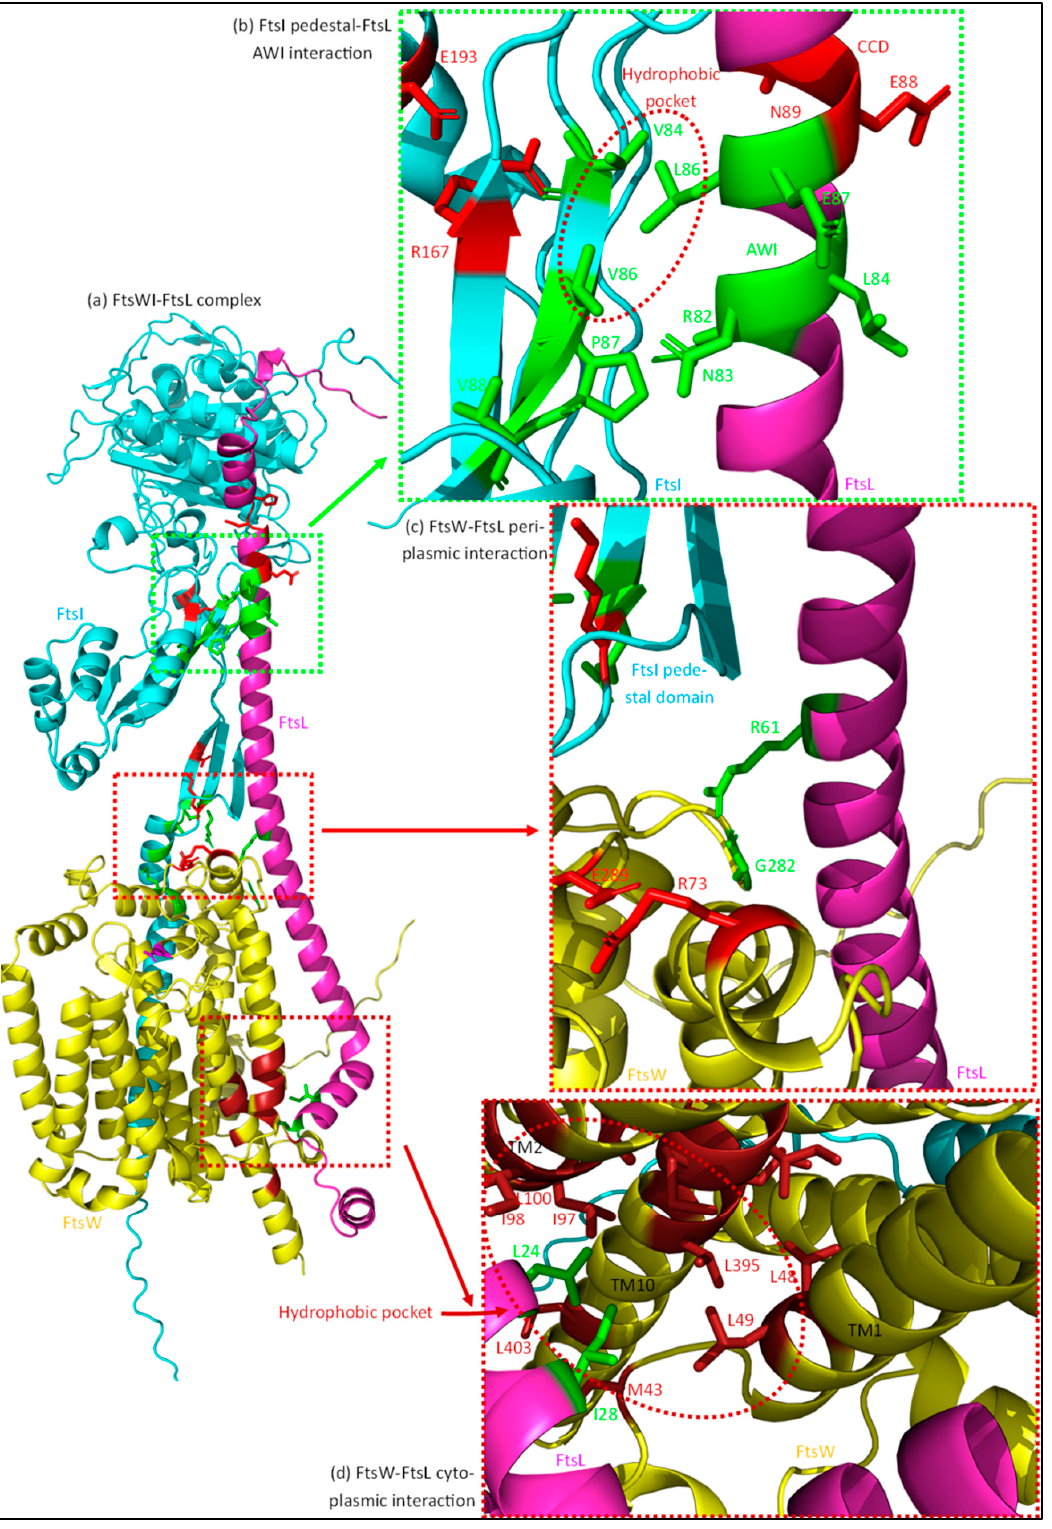
Figure 12. Interactions between FtsL and FtsWI. FtsL interacts with multiple regions of FtsWI, which likely leads to a stable active conformation. ( a ) The complex formed between FtsW (yellow), FtsI (cyan) and FtsL (purple) is shown. ( b ) A periplasmic interaction between the FtsL AWI domain